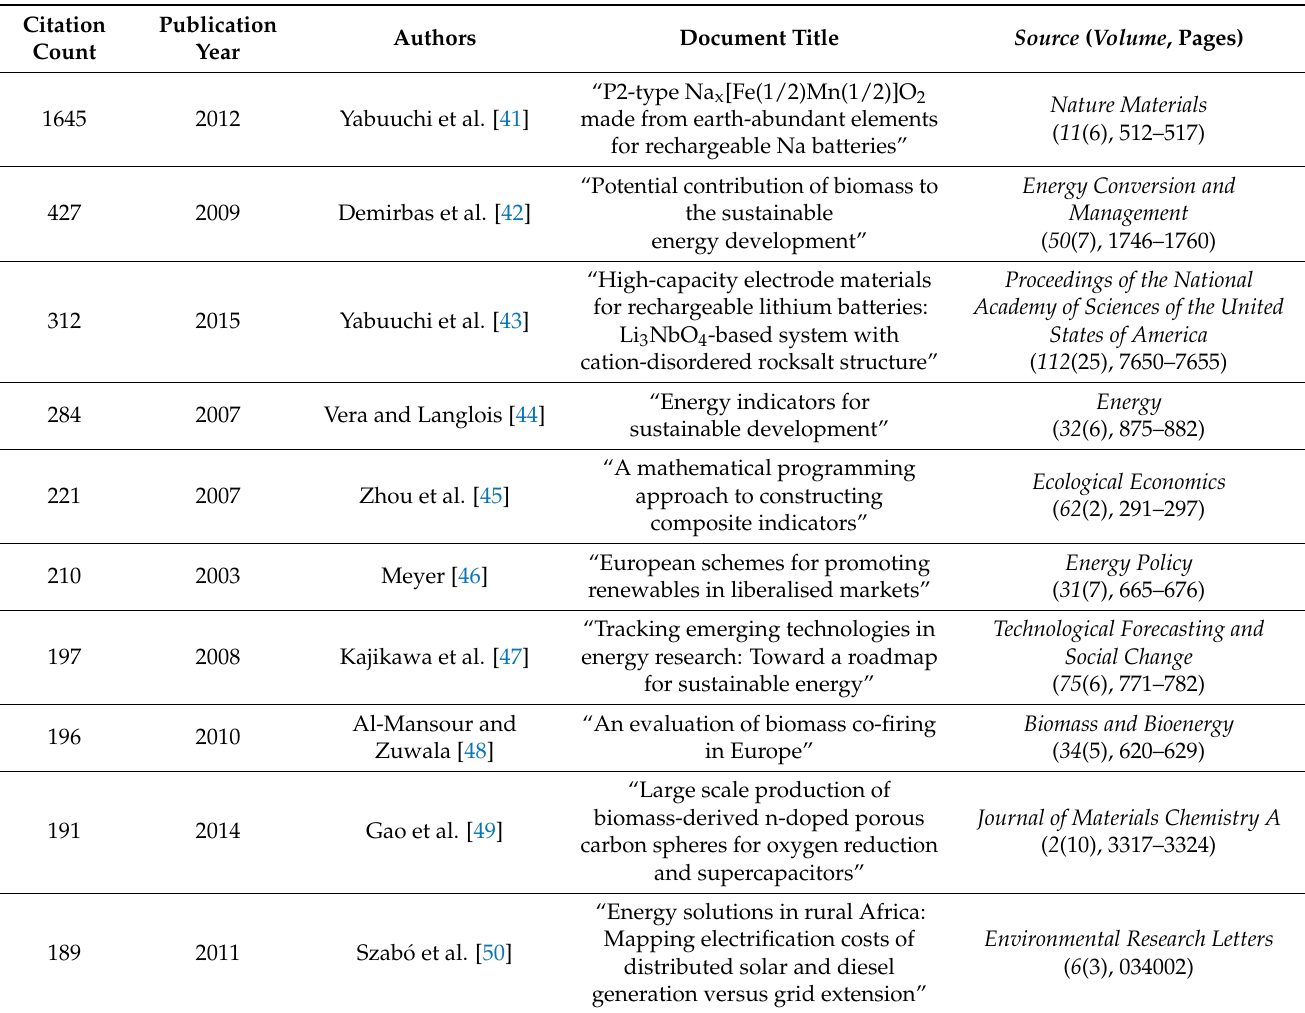
Table 2. Most frequently cited